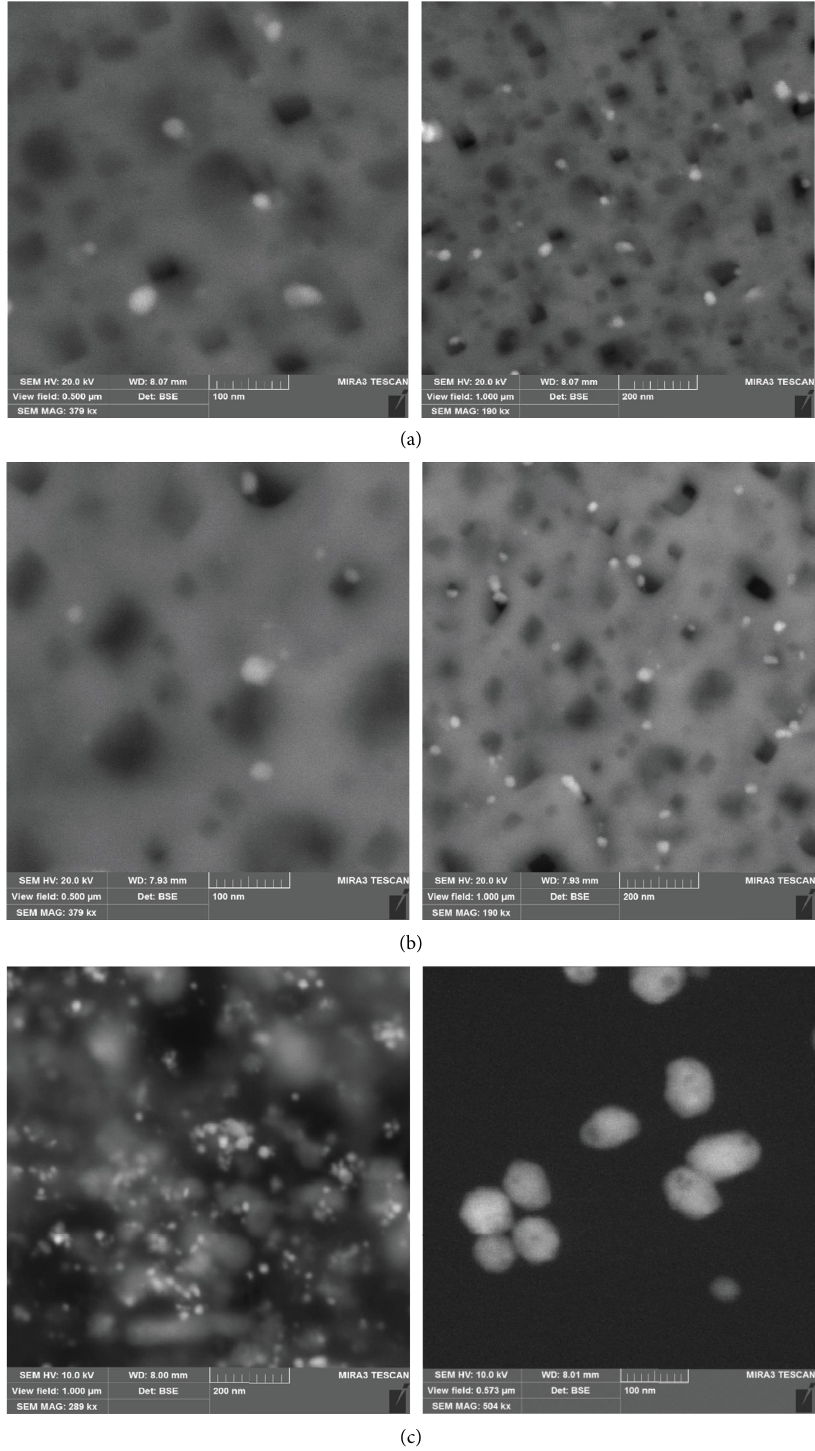
Figure 7: SEM analysis of “green” synthesized AgNPs (a) with grape pomace extract obtained by P-GPE (b), B-GPE (c), and W-GPE